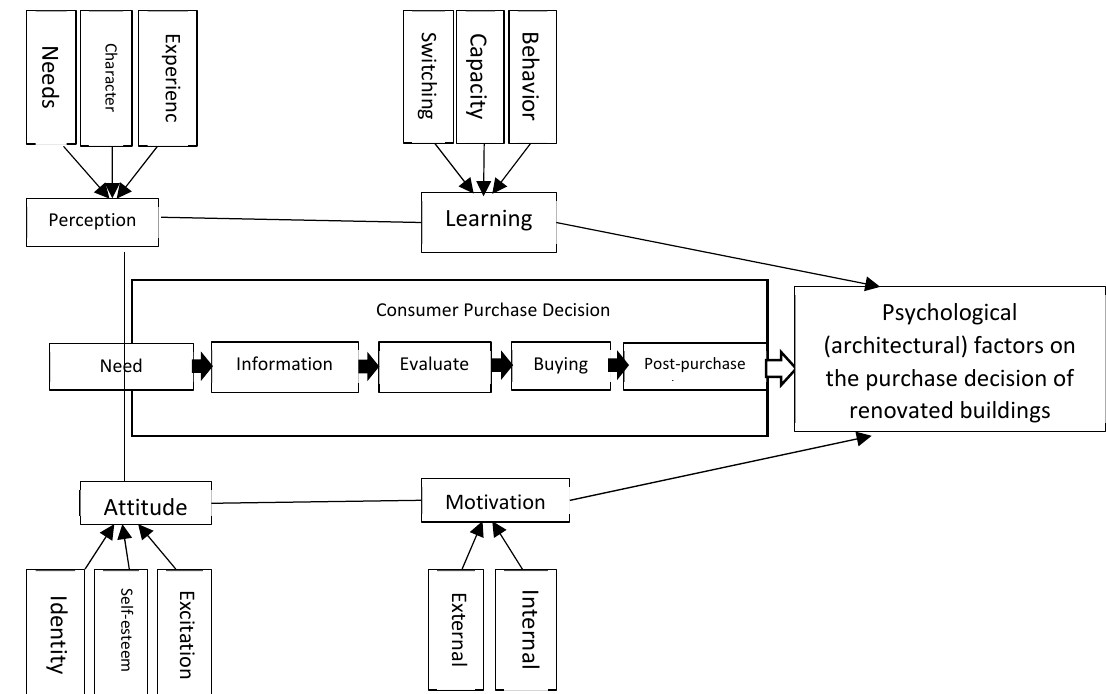
Fig. 2 : The final model of psychological (architectural) factors on the purchase decision of renovated buildings